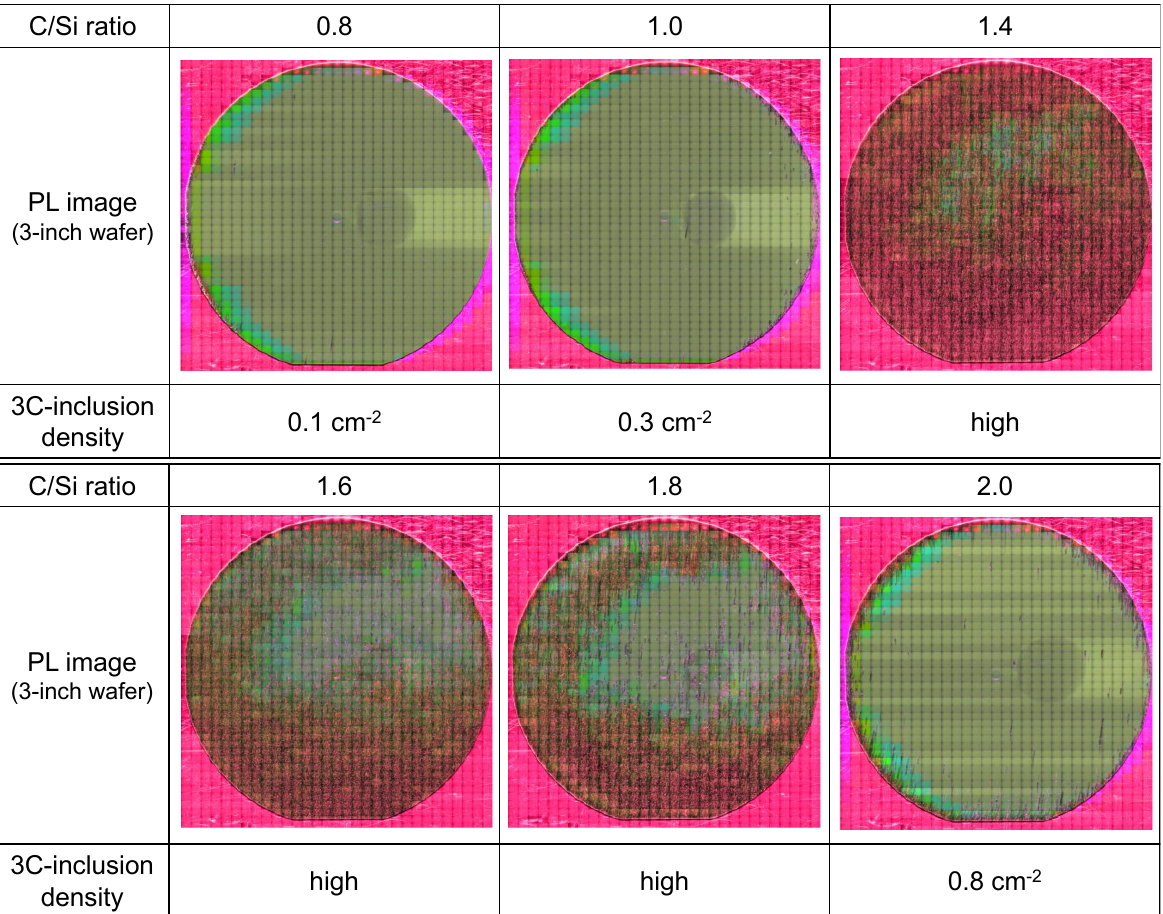
Figure 5. PL images and 3 C -inclusion densities of epitaxial layers grown at various C/Si ratios with in situ etching to a depth of 0.9 μm.